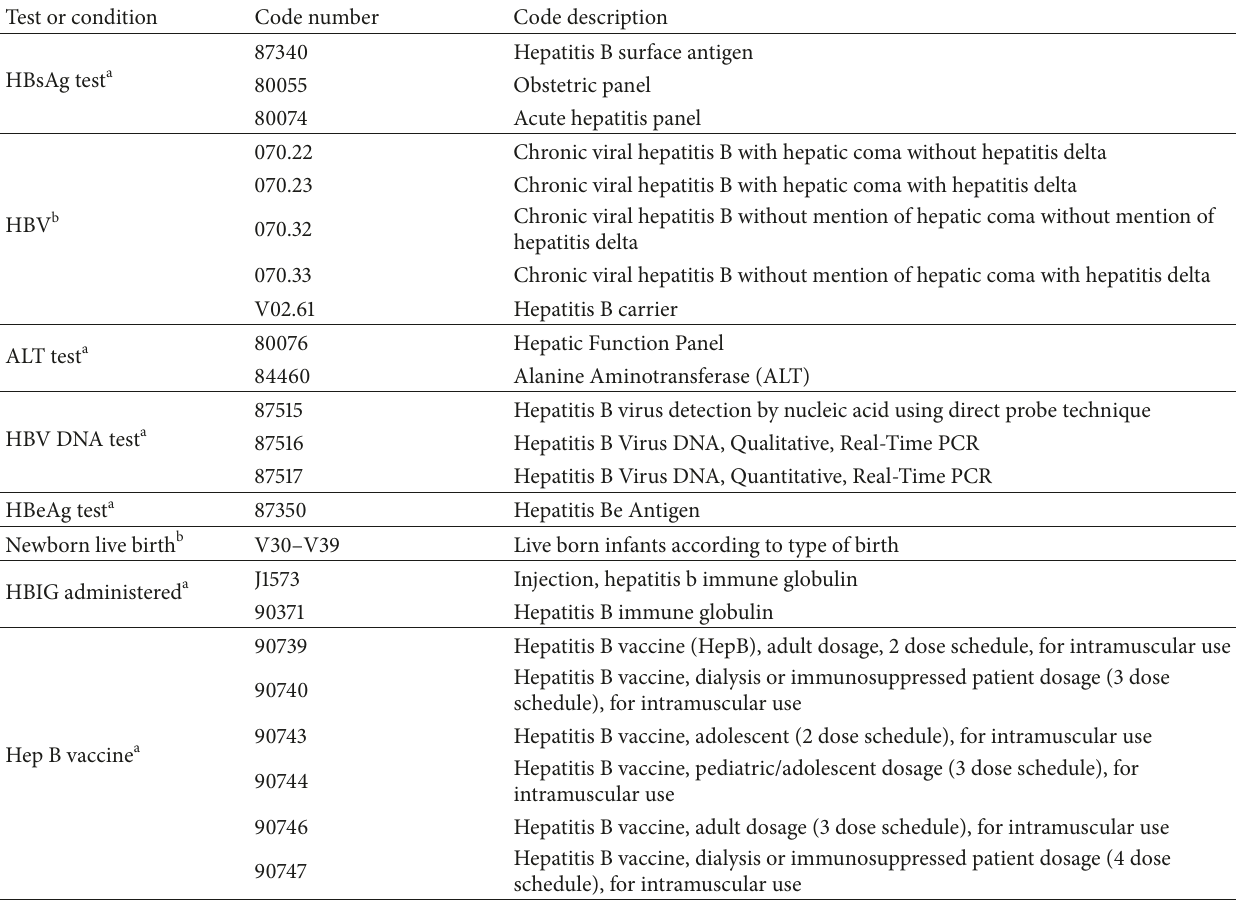
Table 1: Procedure a and diagnosis codes b used to identify hepatitis B diagnosis, testing, care, and